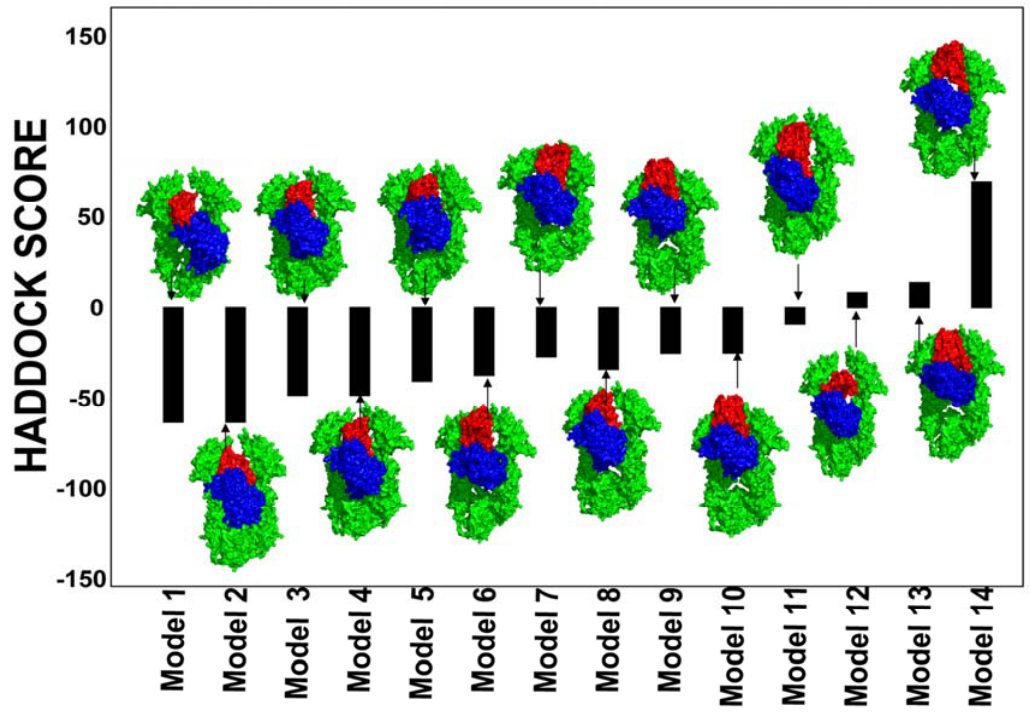
Figure 6. Structures and Energies of the Hsp90-Cdc37-Cdk4 Docked Complexes. The presented docked solutions are the low-energy binding modes obtained after stages of 3- body docking, refinement and clustering. Structures of the Hsp90-Cdc37-Cdk4 complexes are aligned with their respective HADDOCK score. A surface-based protein representation is used. The Hsp90 dimer is shown in green, Cdc37 is colored in red and Cdk4 is displayed in blue. Structural analysis of the docked solutions shows a gradual improvement and consolidation of the Hsp90-Cdc37 and Cdc37-Cdk4 intermolecular interfaces as the HADDOCK score of the docked complexes